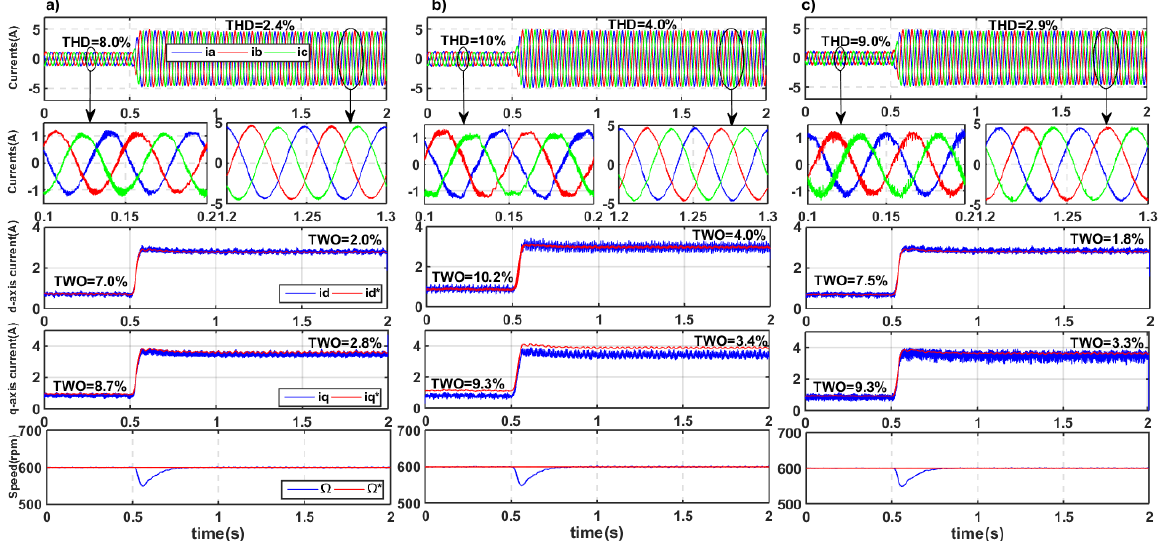
Figure 8. Experimental results for 600 rpm and load torque variation: ( a ) MBPCC with nominal parameters, ( b ) MBPCC under the influence of parameter variations (0.3xLd, 0.3xLq), ( c ) proposed GW − MFPCC.